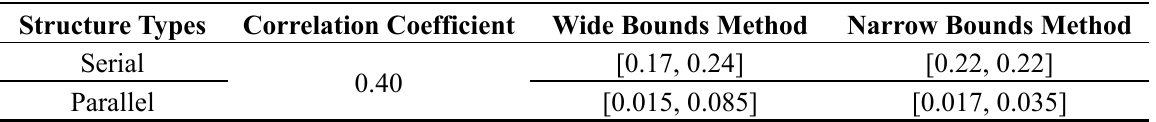
Table 4. System failure probability of rainfall forecast errors and flood forecast errors for DHF reservoir (with bounds